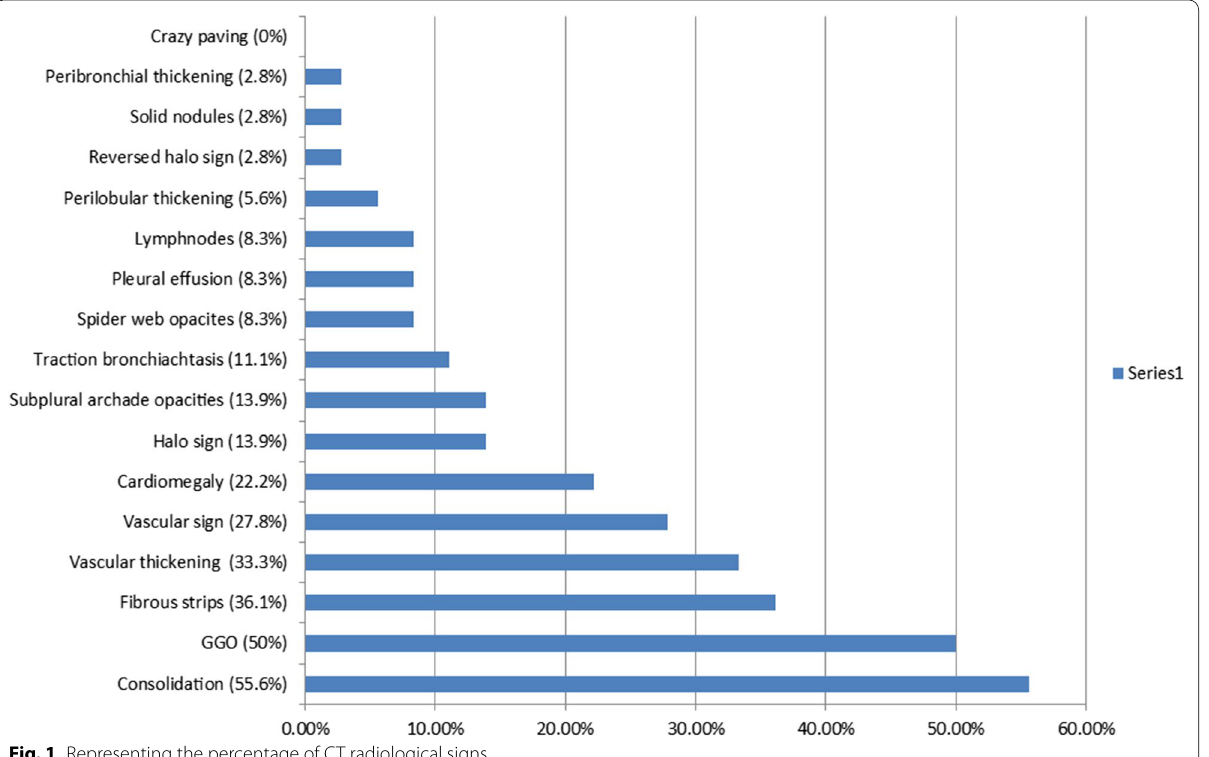
Fig. 1 Representing the percentage of CT radiological signs